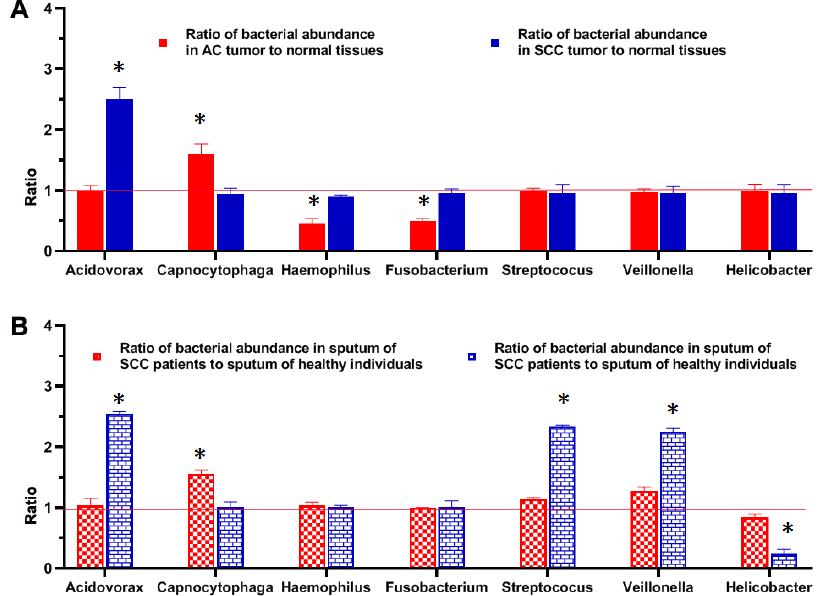
Figure 3. Comparison of abundances of bacteria in tumor tissues of lung cancer patients and sputum of lung cancer patients and controls. Relative abundances of bacterial genera in tumor tissues ( A ) and sputum of lung cancer patients ( B ) as compared with their normal counterparts. High abundances of bacterial genera in tumor tissue or sputum specimens are shown above ratio of 1 (red line), whereas low abundances in tumor tissue or sputum specimens are shown below ratio of 11 (red line). *, p < 0.05 determined by a Mann–Whitney U test).